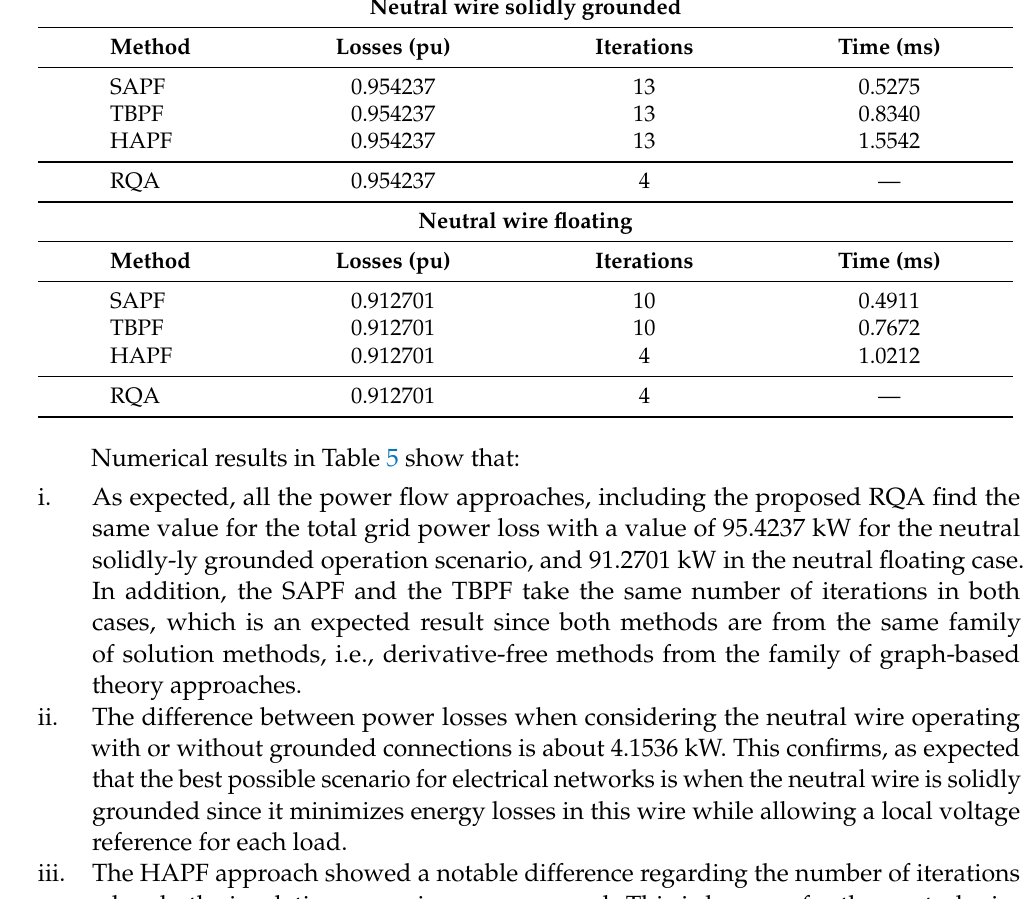
Table 5. Comparison between power flow methods and the RQA for solidly-ly grounded and neutral floating scenarios in the 21-bus grid.